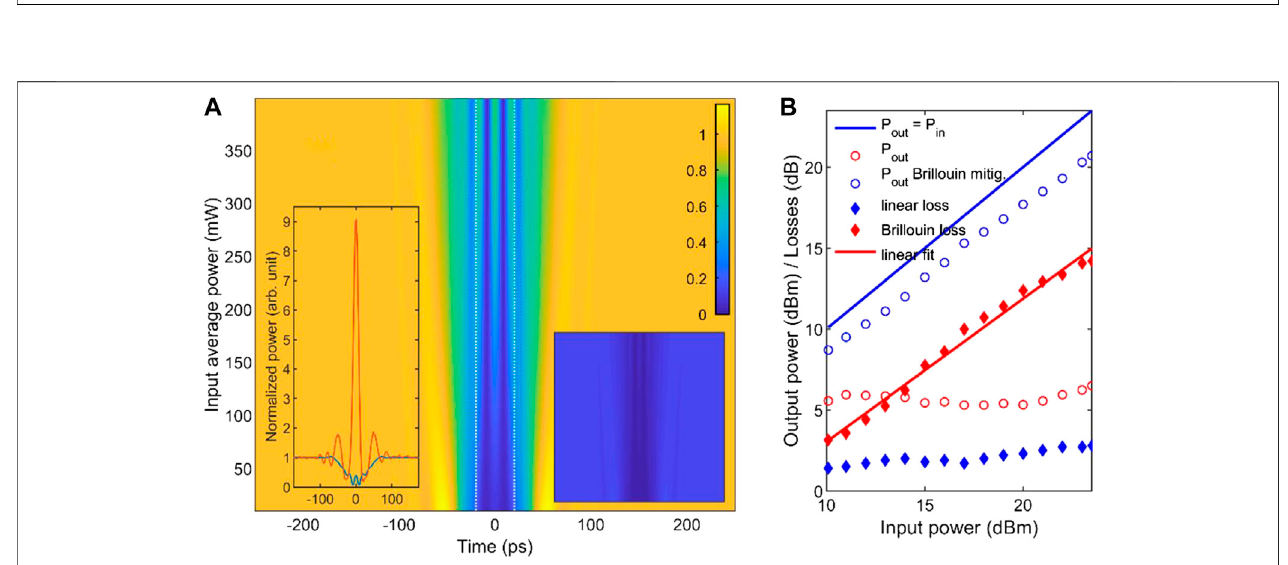
FIGURE3|(A) Numericalsimulationsofthepower-dependentoutputtemporalintensitypro fi lesbasedontheNLSEincludingconstantlosses.Intensitypro fi lesare normalized by the intensity of the output continuous background. Left inset: comparison of the experimental and numerical results (red and blue lines, respectively) obtained for an input average power of200 mW. Right inset: numerical results plotted with the same temporal and power ranges as Figure 2C and with the same color scale. (B) Experimental measurement of the output average power (circles) according to the input average power. Results without any Brillouin mitigation (red circles)arecompared withresultswhenmitigationisapplied(bluecircles).Diamondsrepresent theleveloflosses,thatis,experienced:linearlosses(bluediamonds)and nonlinear losses (red diamonds). The evolution of the experimental nonlinear losses according to the input power is fi tted by a linear trend (solid red line).